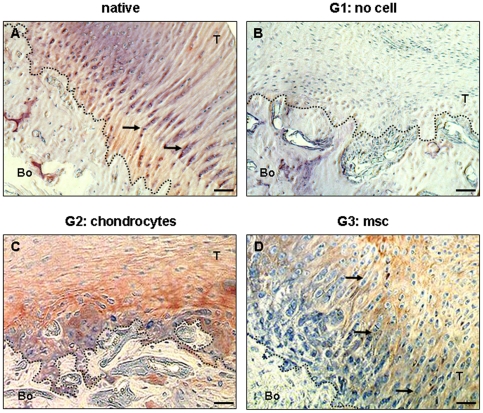
Restoration of enthesis organization by MSC-injection 45 days post repair.Immunohistochemical staining for collagen II was performed on native entheses (A) and 45 days post-repair enthesis from control G1 (B), chondrocyte-injected G2 (C) and MSC-injected G3 rats (D). A) Native enthesis contained columns of chondrocytes (arrows) at the bone-tendon junction and there was positive collagen II immunostaining at the junction. B) Control bone-tendon junction 45 days after surgery showing the absence of both cells and type collagen II. In contrast, the bone-tendon junctions of repairs with cells injected were intensely stained for collagen II (C and D). However, the collagen II distribution was not uniform and there were no chondrocyte columns in chondrocyte-injected rats (C), whereas the repairs of MSC-injected rats 45 days after surgery showed uniform type II collagen distribution at the bone-tendon junction and the chondrocytes formed columns (arrows) (D). Scale  = 200μm. T, tendon; Bo, bone. Dotted lines delimitate bone and tendon.